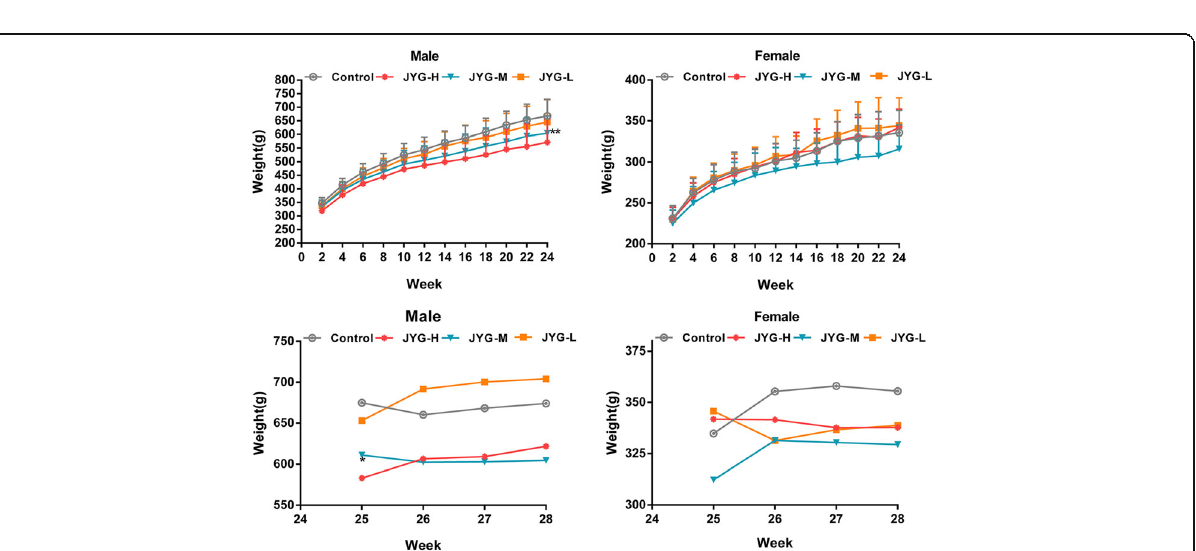
Fig. 1 Body weight in the control and JYG-treated groups in the chronic toxicity test. Note: JYG-H, JYG-M, JYG-L: Jueyin granules high-dose, medium dose, low-dose group, respectively. The values are expressed as mean ± SEM ( n = 10 rats for 3 months; n = 17 – 19 rats for 6 months; n = 10 rats for 1 month recovery). * P < 0.05; ** P < 0.01 statistically significant compared to control group